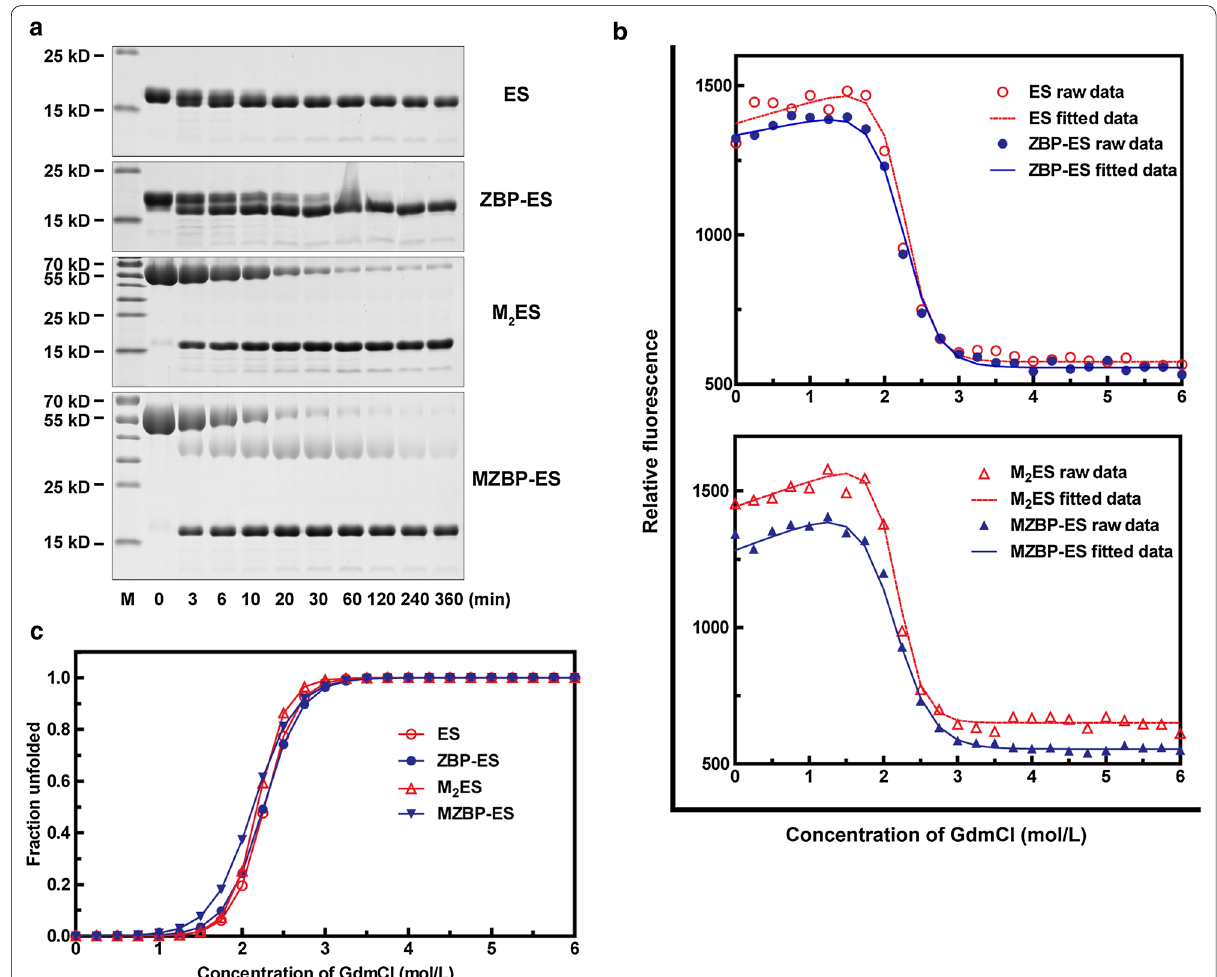
Fig. 2 Stability of ES variants under certain conditions. a Trypsin digestion profiles of ES variants for the indicated time. b and c Proteins were incubated with different concentrations of guanidinium chloride ( GdmCl ), and GdmCl-induced denaturation of ES variants was monitored with